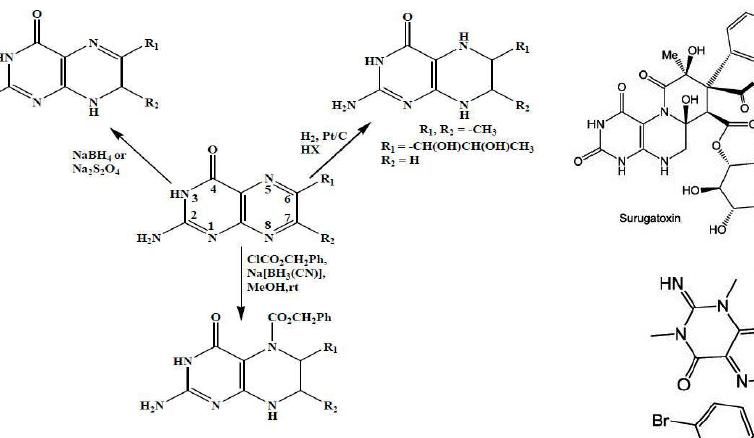
Figure 6: Synthetic routes for reduced pterins.